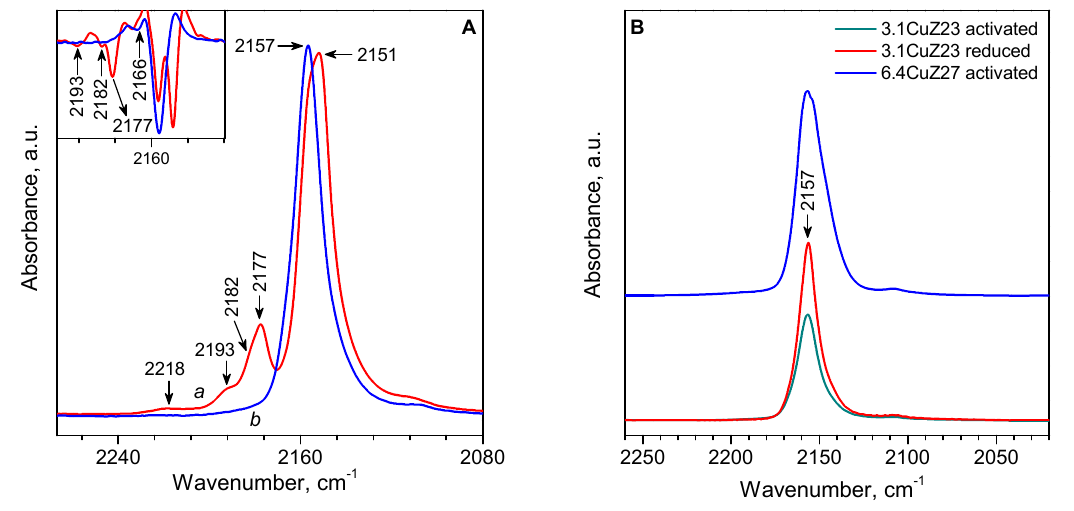
Figure 8. ( A ) IR spectra of CO adsorbed on activated 3.1CuZ23(AE): 10 mbar CO at room temperature (a) and after evacuation at room temperature (b). ( B ) IR spectra of carbonyl complexes on different samples stable after evacuation at room temperature.